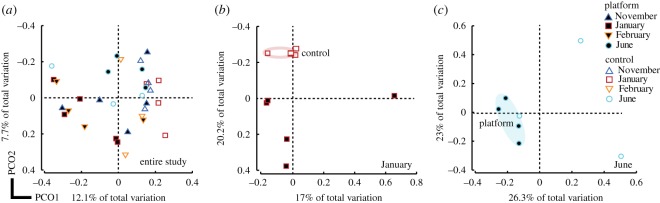
Two-dimensional principal coordinate ordination plots visualizing dissimilarity between bacterial communities (unweighted UniFrac distance) associated with colonies of the coral Acropora millepora remaining visually healthy throughout the study at control (white symbols) and platform sites (black symbols) (a) throughout the eight-month study, (b) in January only, and (c) in June only. Blue triangles: November samples; red squares: January samples; orange triangles: February samples; and blue circles: June samples.